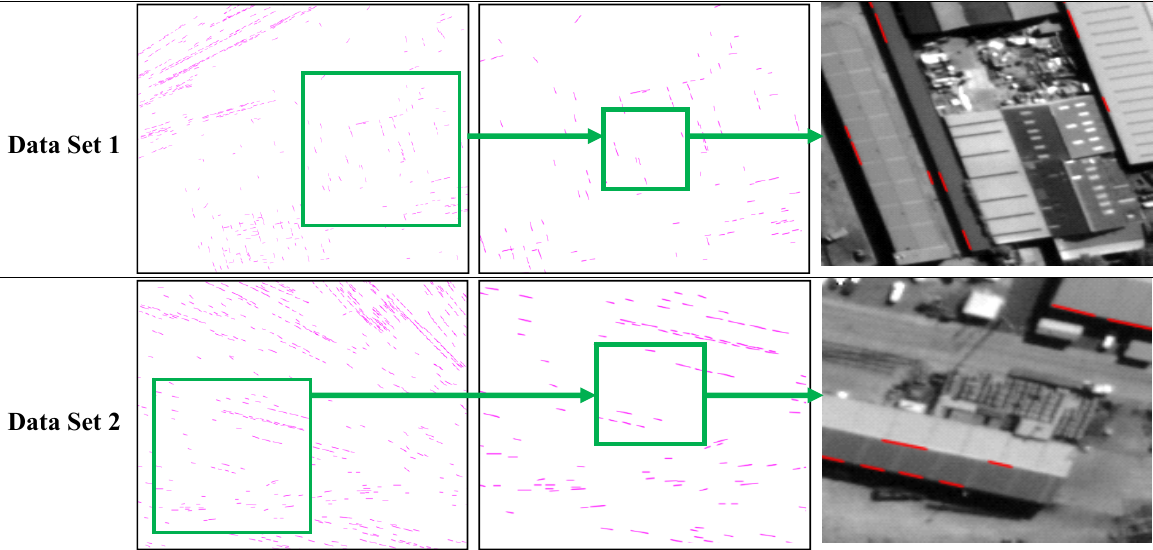
Figure 7. Selected image edges in both data